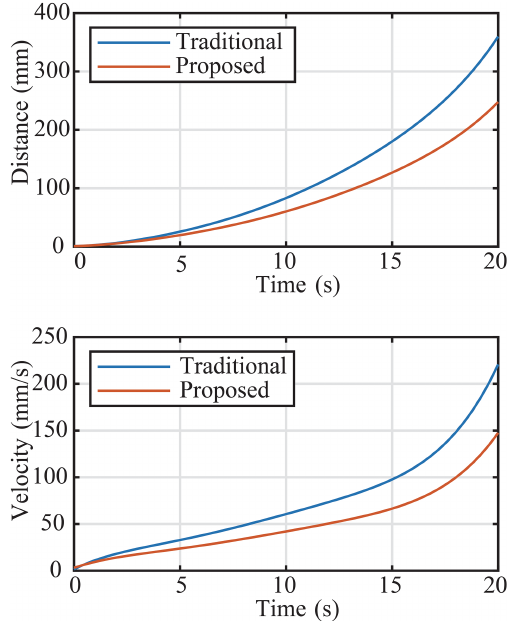
Figure 16. Diagram of the distance and velocity of model’s CoG moving on the x